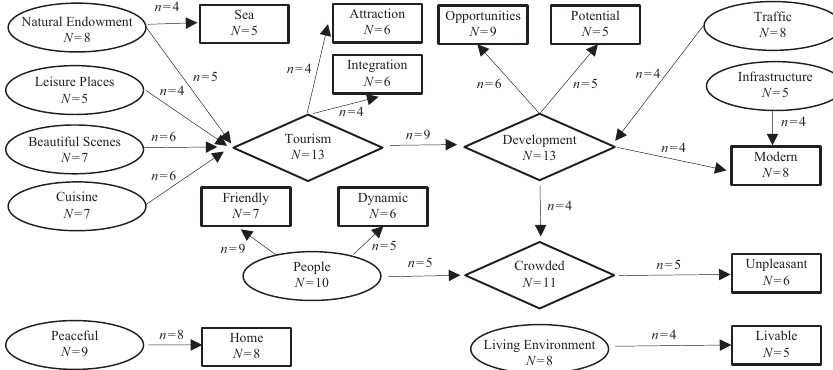
Figure 3. Danang consensus map in students ’